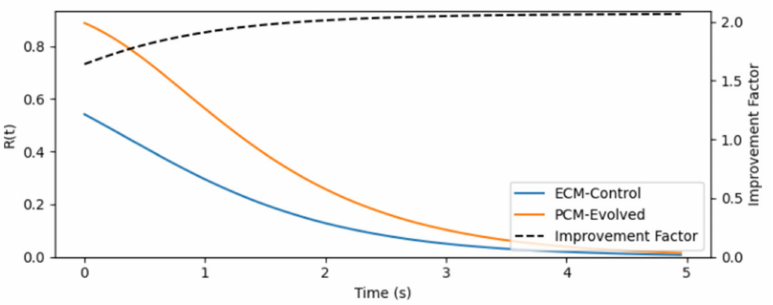
Figure 33. LSSE output for the MTBRF and Reliability Improvement Factor of an experiment with 1000 MASs, with leaf node transfer restricted, with 6 tasks and 5 agents in each MAS.